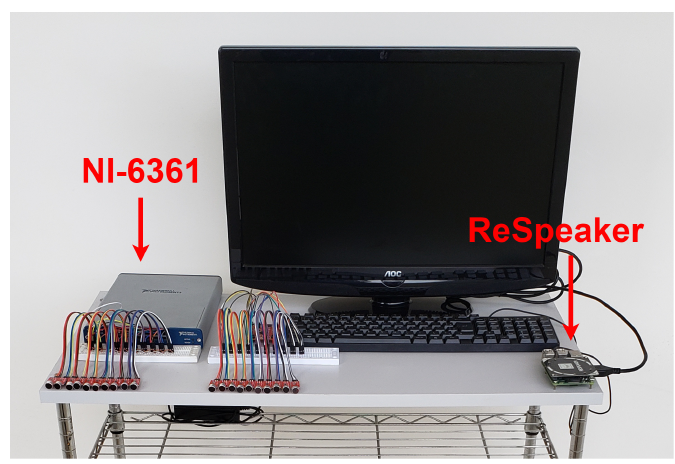
Figure 1. Experimental measurement setup.